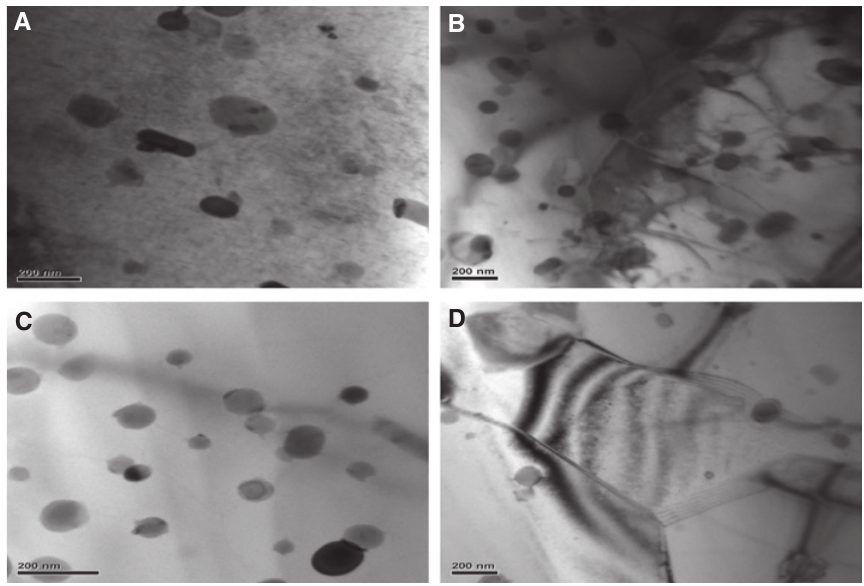
Figure 10: TEM micrograph of (A) PM, (B) AW, (C) AA and (D) STA